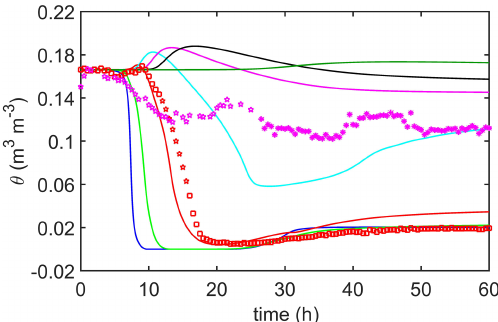
Figure 10. Volumetric soil moisture, after temperature correction to the TDR probe (Massman et al., 2010a, Appendix A), during the 26 April 2004 MEF burn, with modeled (solid lines) and ob- served (symbols) measurements. The color coding for depth is the same as that in Fig. 8, but observations of soil moisture are taken only at two depths, i.e., 5cm (red) and 15cm (magenta). The red stars are interpolated values and appear to be fairly trustworthy. The magenta stars are less trustworthy because the performance of the 15cm TDR during the early part of the burn was not completely satisfactory.